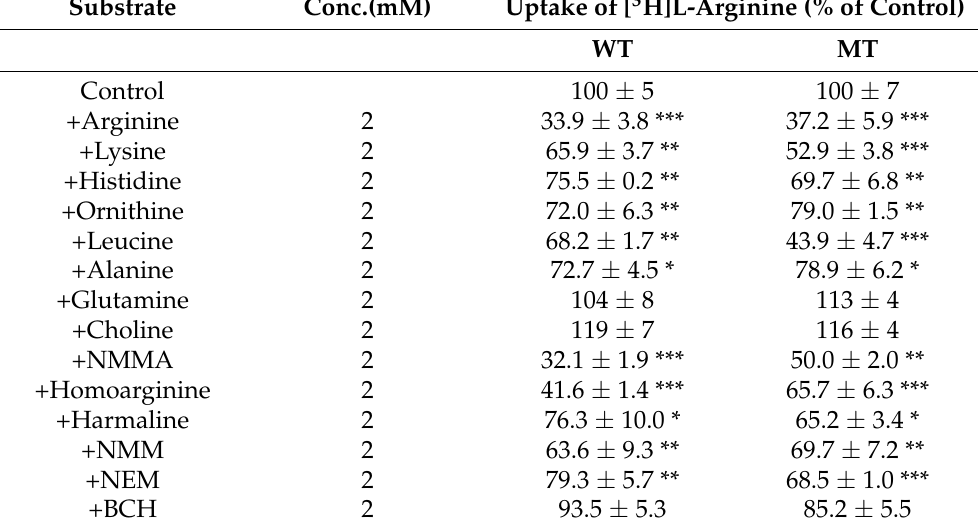
Table 4. Effect of several amino acids and transporter inhibitors on the uptake of [ 3 H]L-arginine by ALS cell